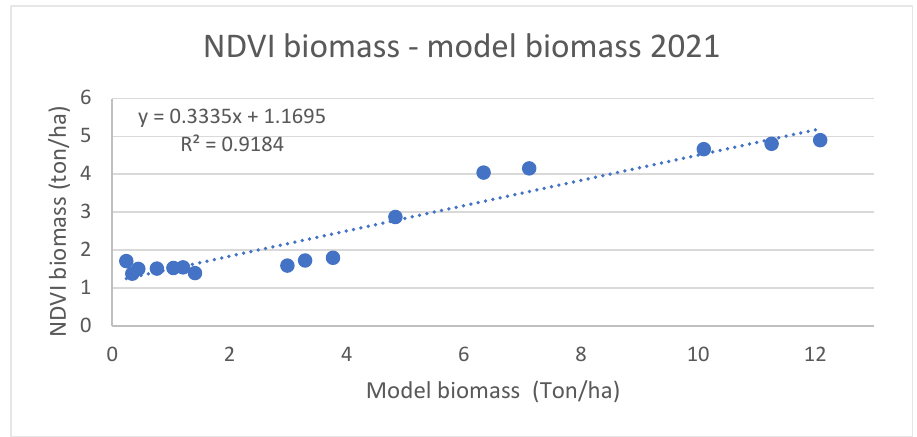
Figure 5. Comparison between NDVI biomass and modeled biomass for winter wheat in 2021.